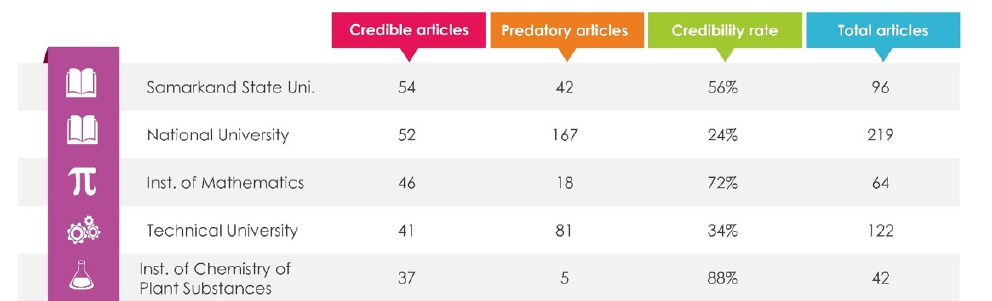
Figure 11. Top-five academic disciplines based on the number of credible publications. As Abdurakhmanov [28] wrote: “For the first time in the world, stable superconduct- ing materials with increased transition temperature to the superconducting state up to 110–150 degrees Kelvin have been obtained with the help of concentrated solar energy”. In chemistry, Uzbek scientists developed a new research field—adsorption-energy stoi- chiometry—with new concepts, theories, and semiempirical results published in an article